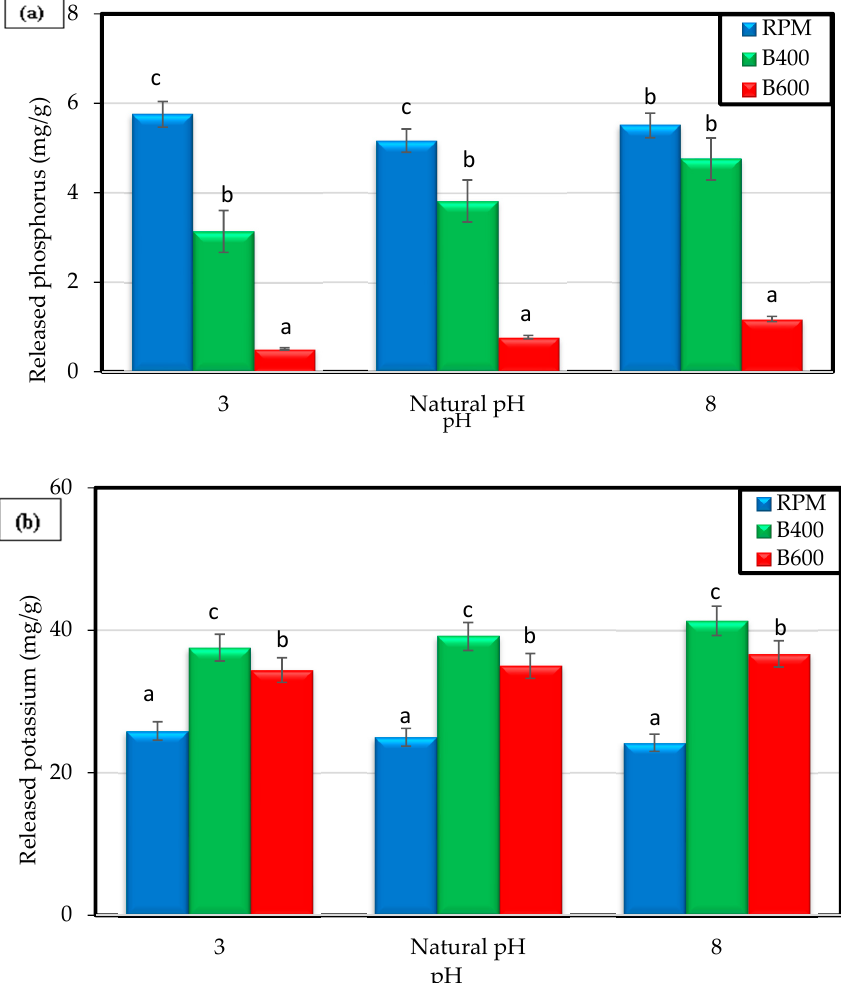
Figure 4. Effect of initial aqueous pH on the phosphorus ( a ) and potassium ( b ) release efficiency from raw poultry manure and its biochars derived at temperatures of 400 and 600 °C (dosage = 10 g L − 1 , T = 20 ± 2 °C). At each pH value, means with the same lowercase letters are not statistically different at p < 0.05.